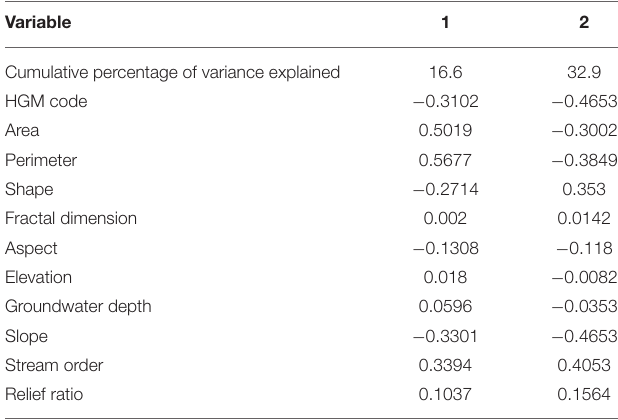
TABLE 3 | Eigenvalues for the principal components analysis for wetland HGM types based on morphometric values of wetland polygons.